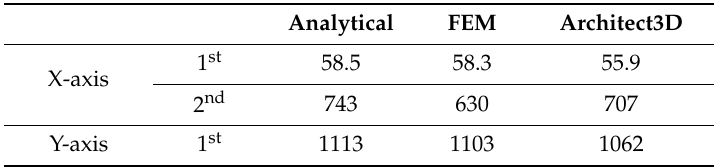
Table 1. Resonant frequencies obtained by analytical estimation, finite element methods (FEM), and